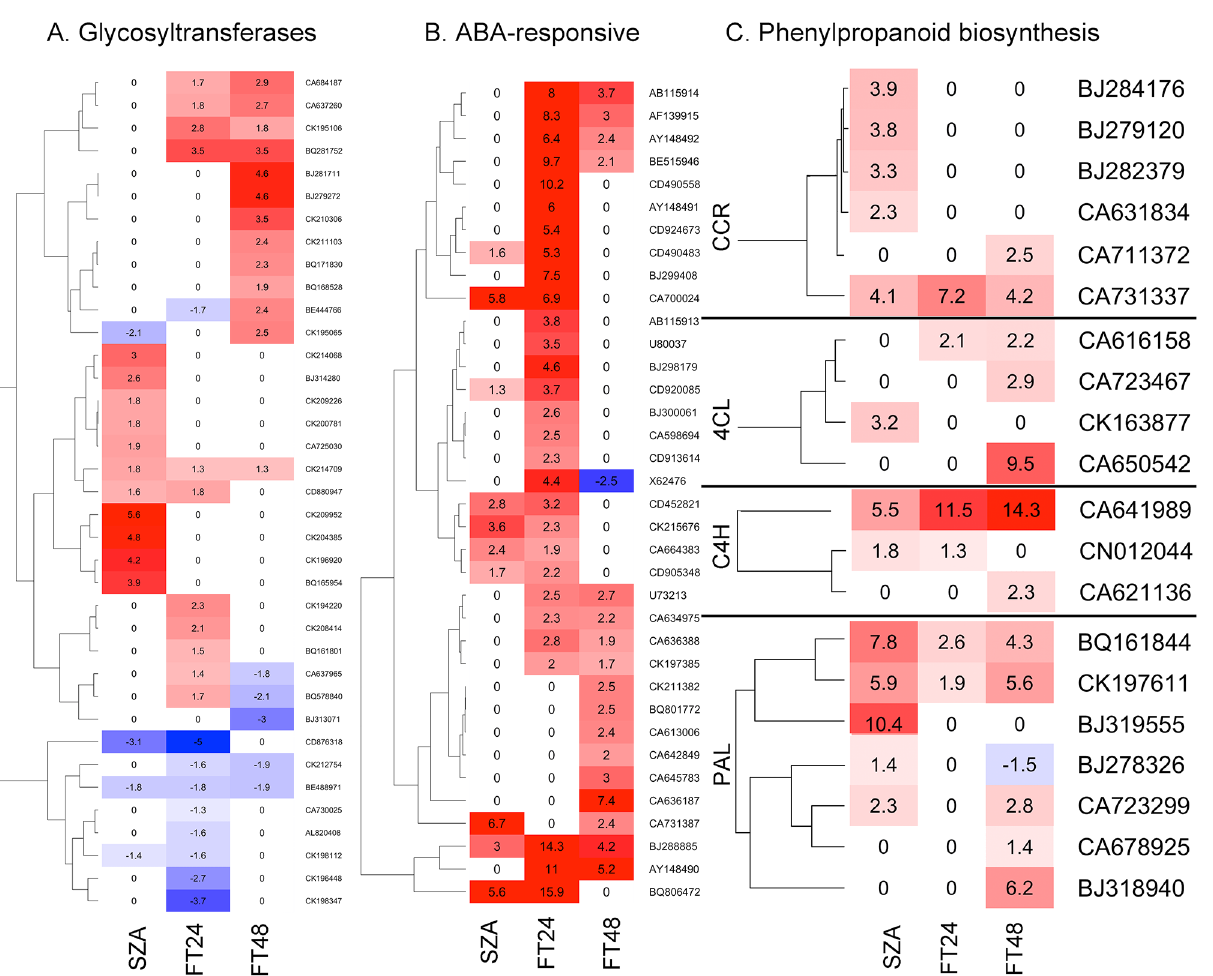
Fig 4. Expression level changes of three classes of genes in wheat crowns following three freezing treatments. SZA: subzero acclimation, − 3°C for 24 hours; FT24: freeze/thaw 24 hours, frozen to − 3°C for 24 hours then allowed to thaw at +3°C for 24 hours; FT48: freeze/thaw 48 hours, frozen to − 3°C for 24 hours then allowed to thaw at +3°C for 48 hours. Responding genes encoding enzymes of the phenylpropanoid biosynthetic pathway were phenylalanine ammonia lyase (PAL), cinnamate-4-hydroxylase (C4H), coumarate-CoA ligase (4CL), and cinnamoyl-CoA reductase (CCR). Expression level fold-changes relative to the control (cold-acclimated plants) are indicated; levels indicated as zero were not significantly different from the control.